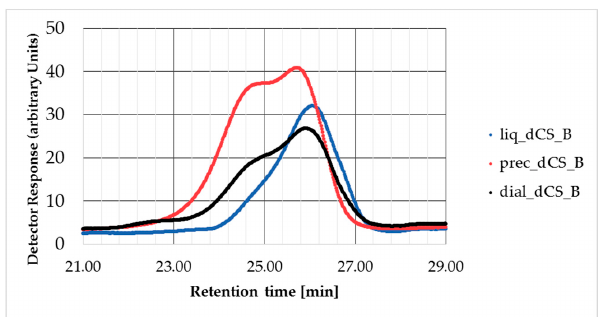
Figure 3. Eluogram of dCS-B between 21 and 29 min of elution time. Black: dial-dCS-B (corresponds to the two other traces combined); red: prec-dCS-B; and blue: liq-dCS-B.